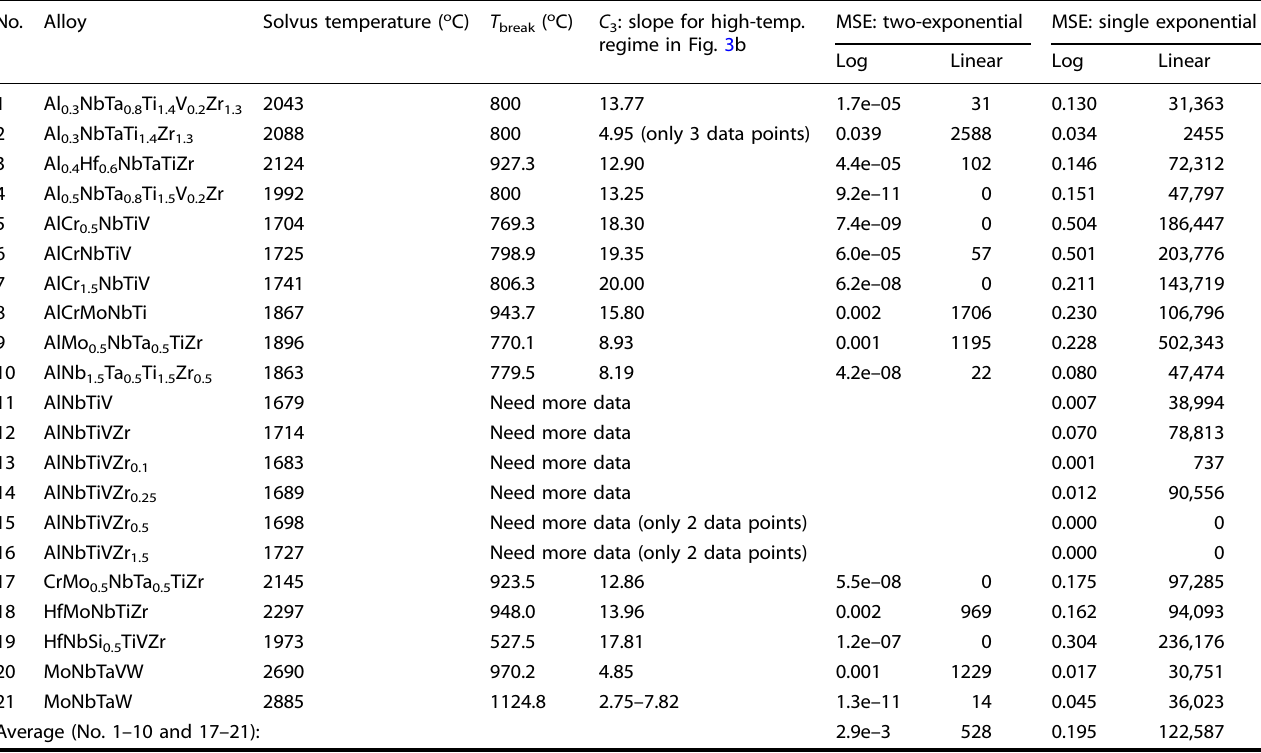
Table 2. Quanti fi cation of ability of compositions to retain ultimate strength at high temperatures. No. Alloy Solvus temperature ( o C) T break ( o C) C 3 : slope for high-temp.